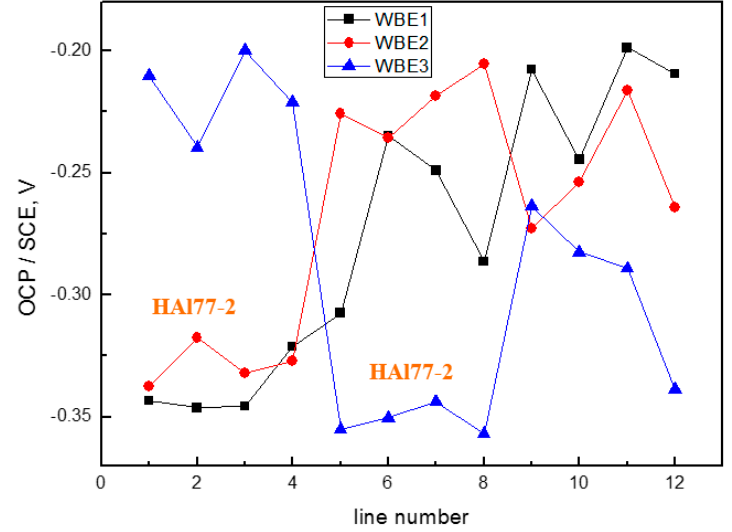
Figure 16. Average OCP distribution of each microelectrode line for the three coupled electrodes after immersion in artificial seawater with 1.5 wt % Cl − at 30 °C.